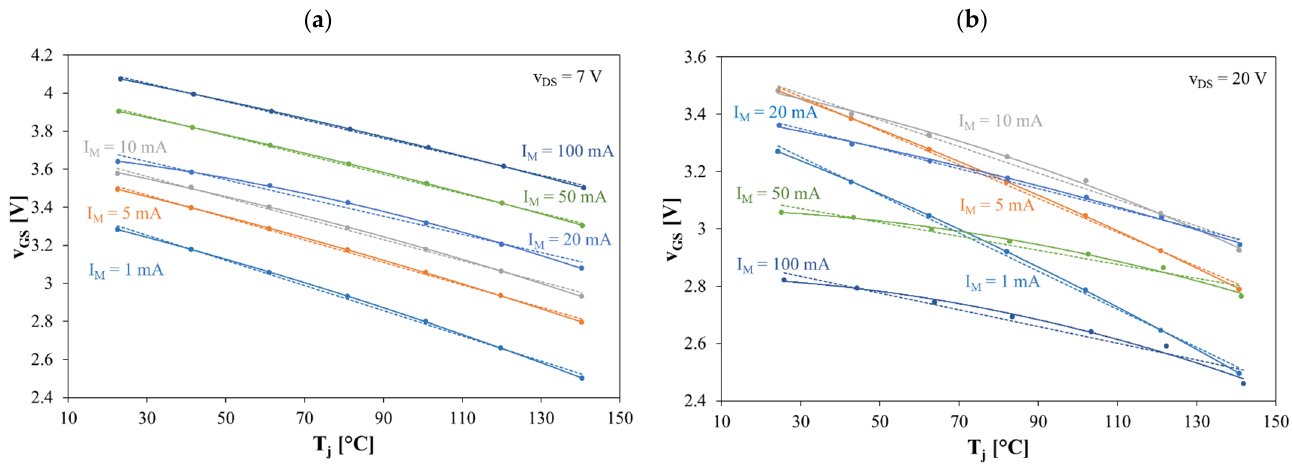
transistor operating in the linear range.